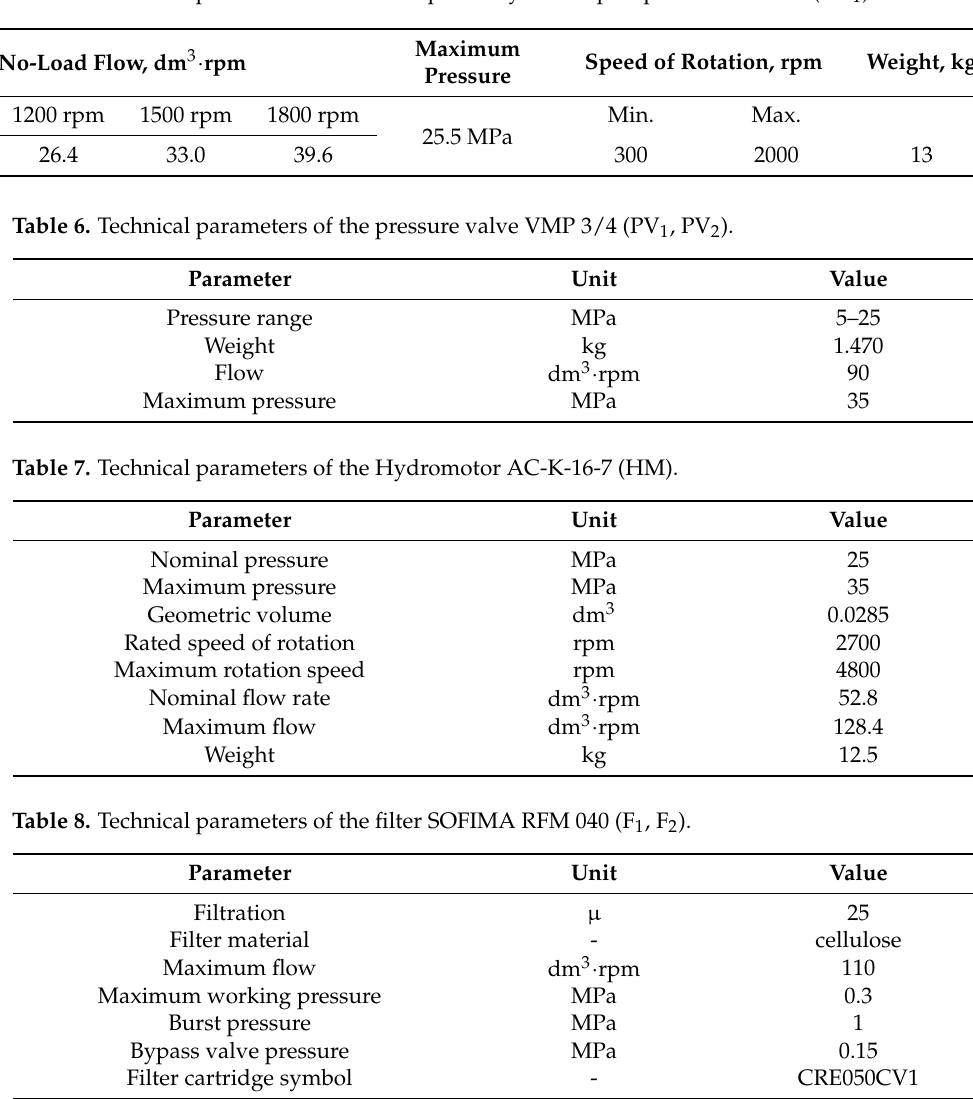
Table 5. Technical parameters of the axial piston hydraulic pump P22-A3-F-R-01 (HP 1 ).